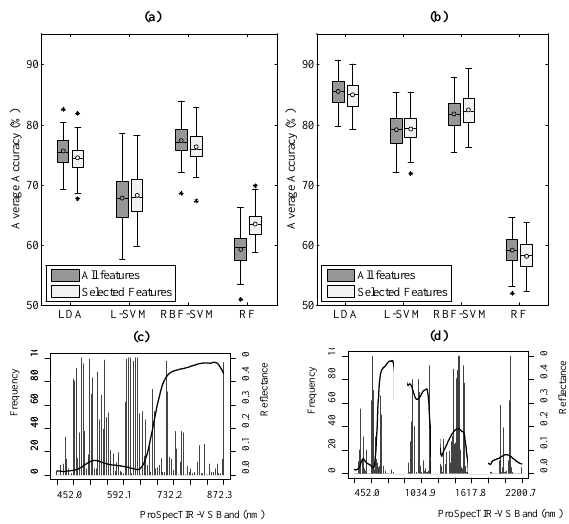
Figure 3. Average accuracy for tree species classification obtained at the pixel scale with different methods, using selected features from either VNIR domain (a), or VNIR+SWIR domain (b). Frequency of selected bands obtained from VNIR data (c) and VNIR +SWIR data (d). The spectral response of a vegetated pixel is plotted in (c) and (d) for clarity.